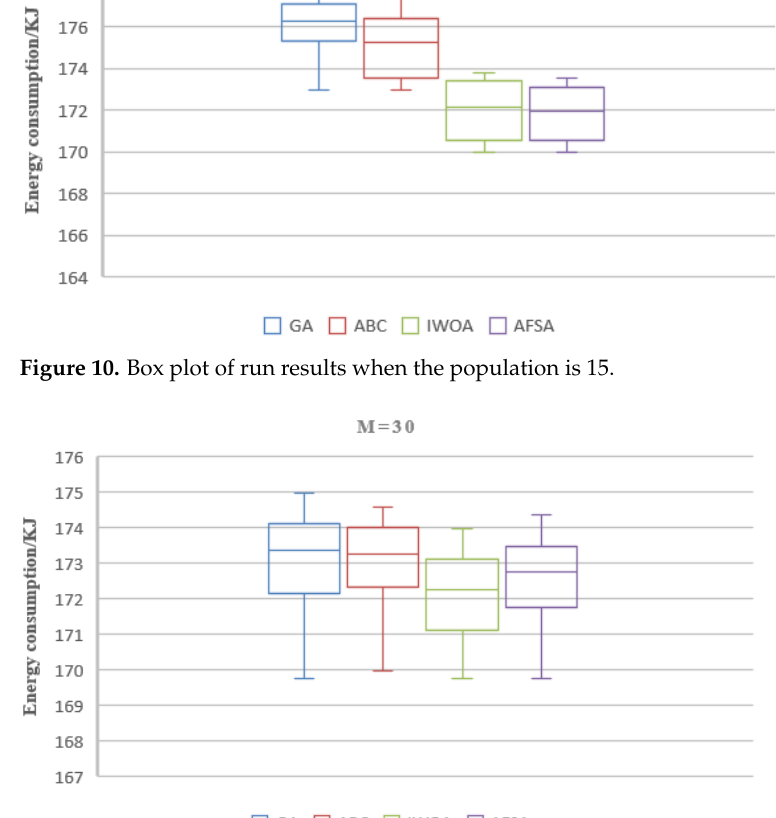
Figure 11. Box plot of run results when the population is 30.